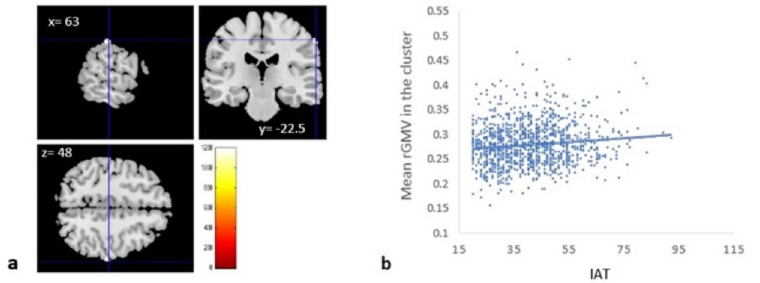
Fig 3. Regional gray matter volumes correlated with internet addiction tendency (IAT) score in young adults. (a) The panels show the areas of significant positive correlation between IAT score and rGMV. The results shown were obtained using a threshold of threshold-free cluster enhancement (TFCE) of p < 0.05 based on 5,000 permutations. A significant positive correlation was found in the right supramarginal gyrus. (b) Scatterplot of the association between IAT score and mean rGMV values of the significant cluster. IAT is positively correlated with mean rGMV of the significant cluster in men (r = 0.10, p = 0.01), and in women (r = 0.099, p =